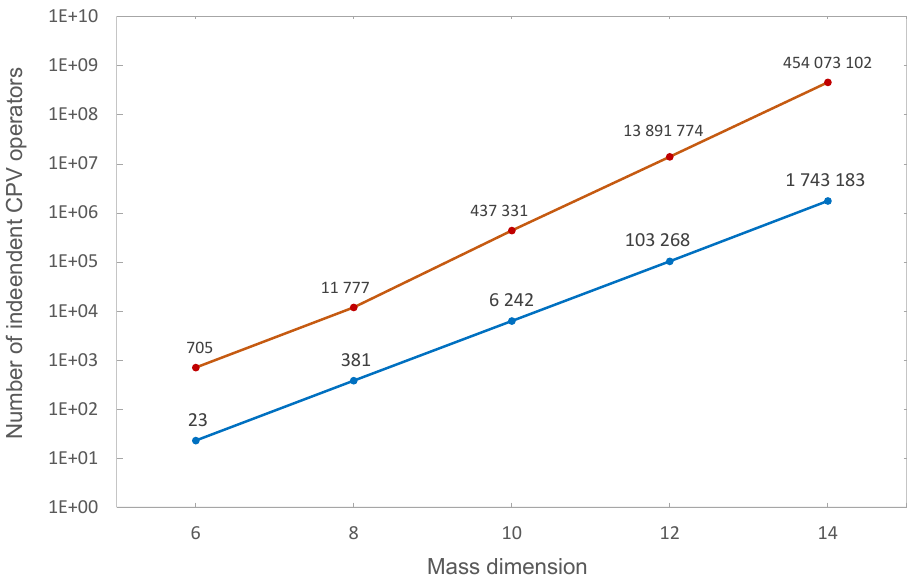
Figure 1 . The number of independent CP-violating operators in the SMEFT up to mass dimension 14. Points joined by the lower solid line are for N = 1 ; those joined by the upper solid line are for f N f = 3 . All operators of odd dimensions can have their phases removed by rephasing up to this dimension, and hence they are not